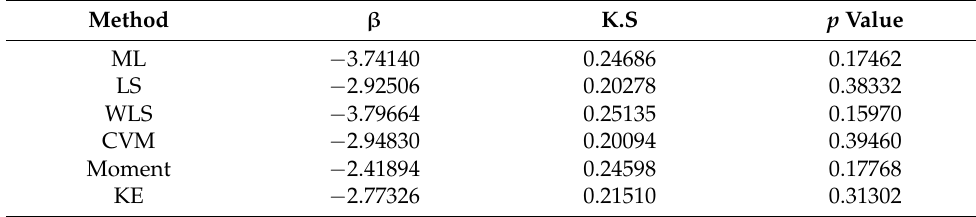
Table 4. p -values for comparing methods under the relief data.